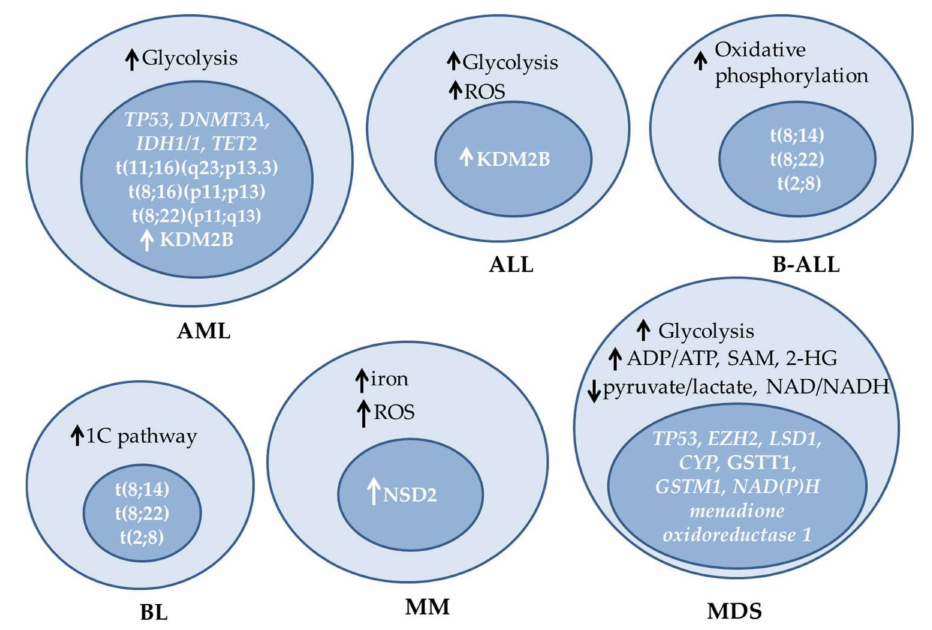
Figure 3. Examples of metabolic alterations, mutations and changes in expression of epigenetic enzymes observed in different hematologic malignancies. ALL: acute lymphoblastic leukemia, AML: acute myeloid leukemia, B-ALL: B-cell ALL, BL: Burkitt’s lymphoma, MDS: myelodysplastic syndromes, MM: multiple myeloma, ROS: reactive oxygen species, SAM: